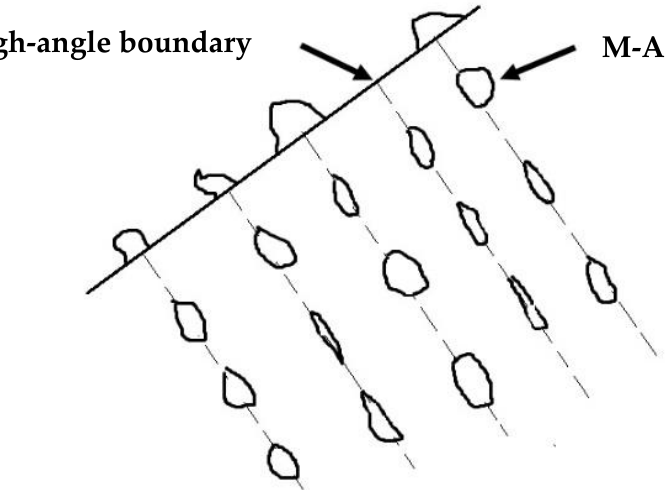
Figure 7. Schematic drawings showing the distribution of M-A in acicular ferrite.